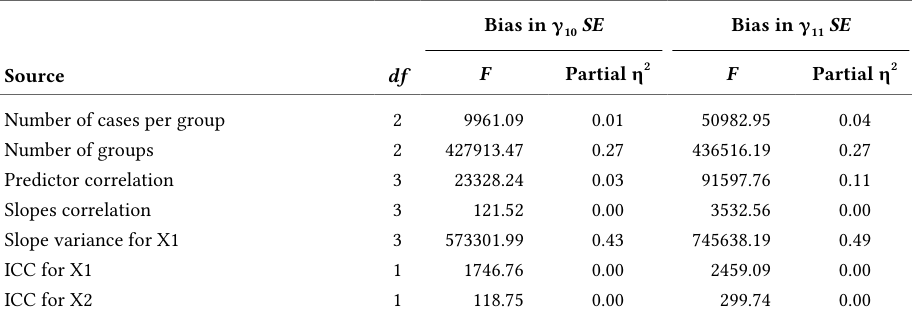
Bias in γ SE Bias in γ SE 10 11 F Partial η 2 F Partial η 2